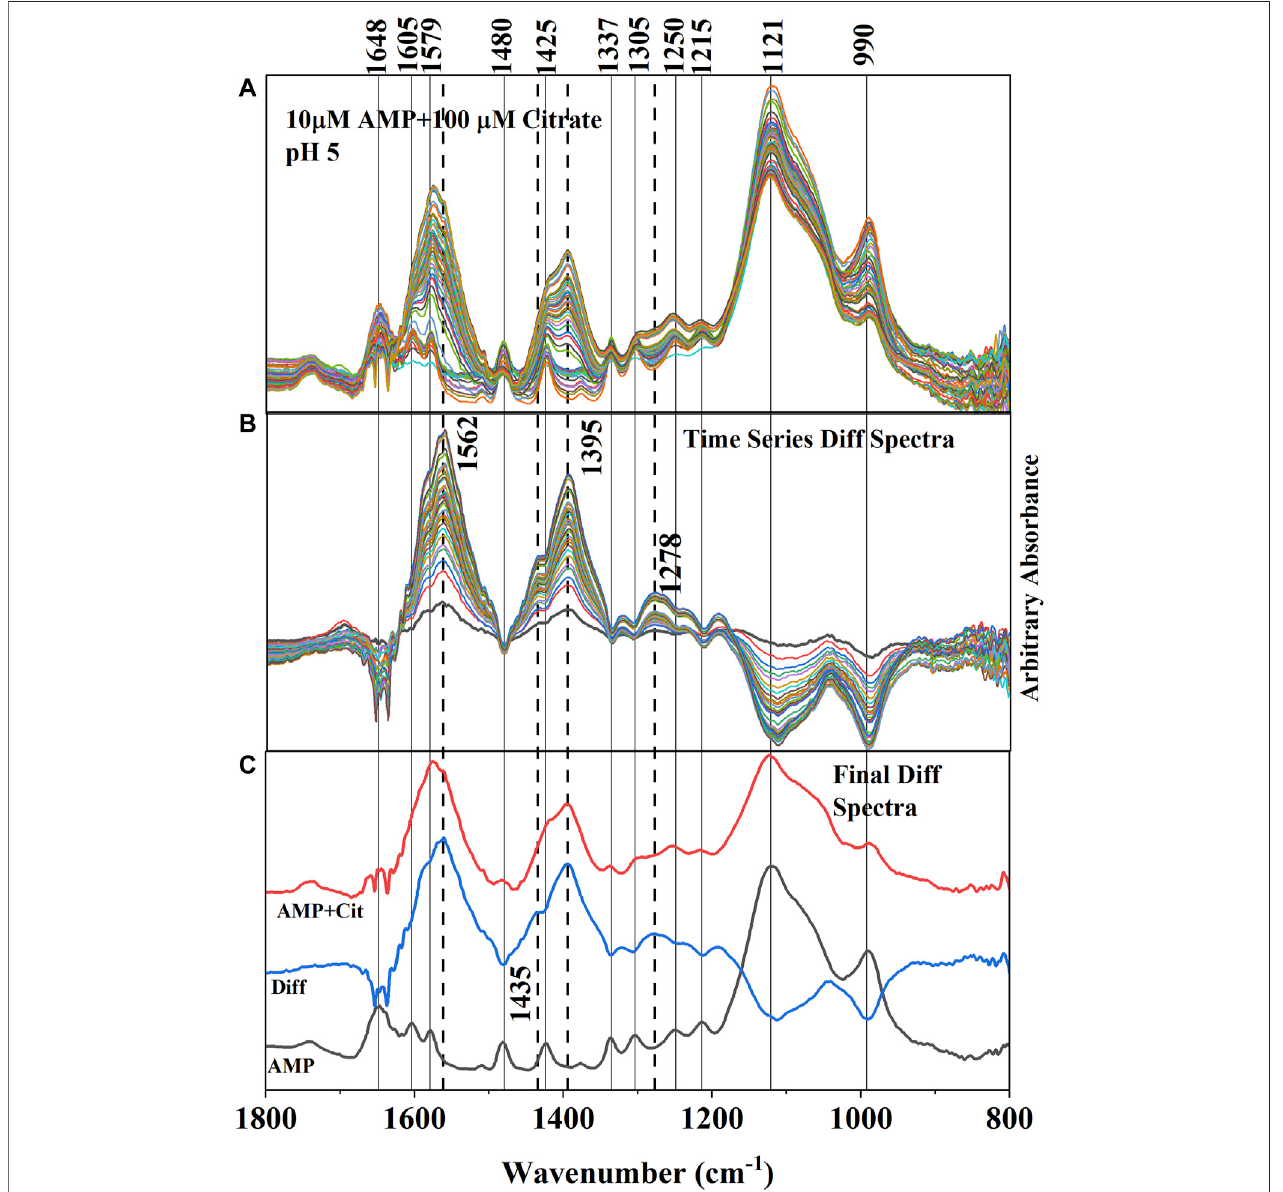
FIGURE4|(A) (UpperPanel)TimeseriesinsituATR-FTIRspectraofadsorbedAMPandcitrateatpH5±0.04.Thetimedifferencebetween fi rstandlastcollected spectra is ~ 2 h. (B) (Middle Panel) Difference IR spectra (obtained by subtracting the spectra collected after and before citrate addition) representing the resultant IR bands due to adsorption ofcitrate and concomitant desorption ofAMP. The negative IR bands are indicating the weakening ofthe IR bands associated with adsorption of AMP. Dotted lines are connecting the new IR bands representing the adsorption of citrate on hematite. (C) (Lower Panel) Final equilibrated IR spectra of